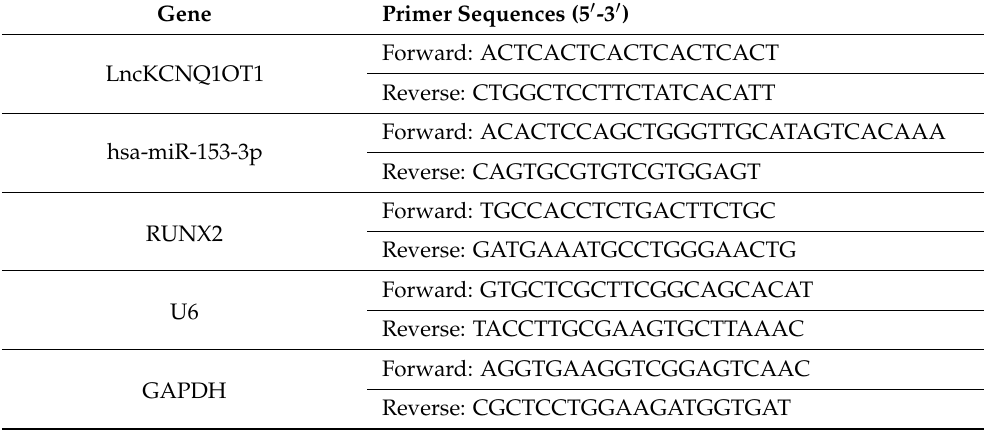
Table 1. The primer sequences for qRT-PCR.